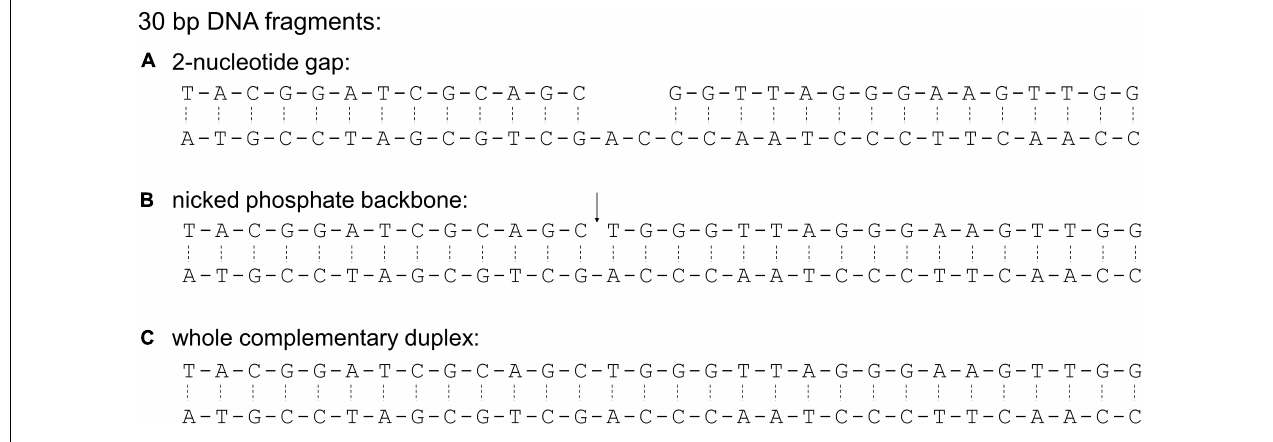
FIGURE 3 | Sequences of 30-bp DNA fragments used in this study. These sequences were used to characterize binding preference of E. coli HU (Castaing et al., 1995). The sequences differ in the presence of a 2-nucleotide gap (A) , a nicked phosphate backbone ( B , indicated by ↓ ), and a fully complementary sequence (C) . The phosphate backbone is indicated with a solid line while hydrogen bonds between complementary base pairs are indicated with a dashed